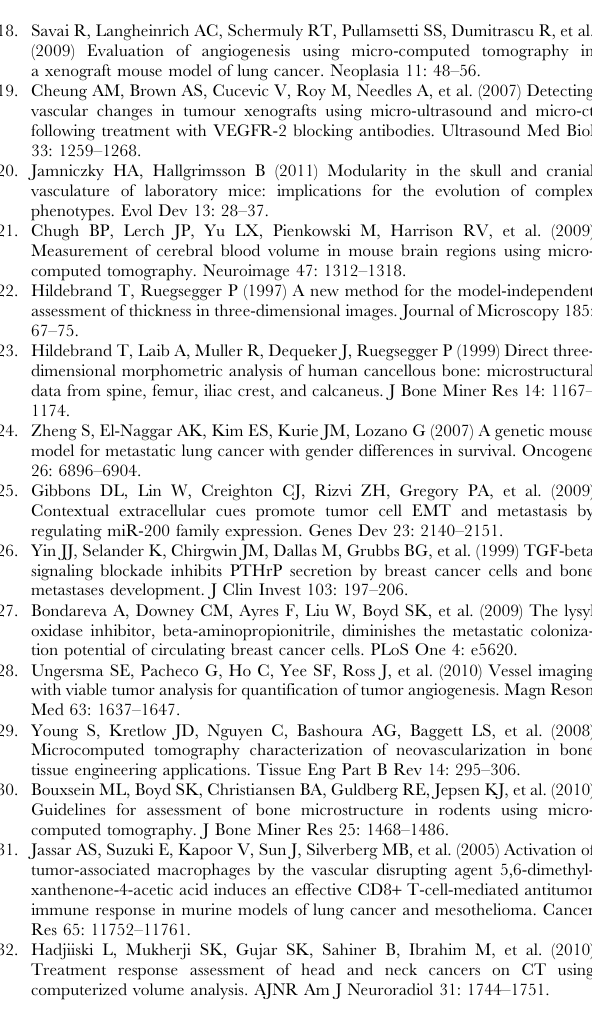
clot-filled vessels in the tumor periphery (scale bars marked on images). Figure S6 Micro-CT quantification of DMXAA treated kidneys. ( A ) 3-D renderings of kidneys (gray) with vasculature (green) from DMXAA-treated and vehicle-control mice. Quanti- fication of vessel volume (VV) ( B ), vessel density (VV/TV) ( C ), vessel number (V.N) ( D ), vessel thickness (V.Th) ( E ), and vessel separation (V.Sp) ( F ), all demonstrate no significant difference between vehicle controls or DMXAA-treated mice. (TIF) Movie S1 3-D rendering of tumor vasculature. 3-D renderings of a Microfil-perfused subcutaneous tumor (344SQ cells) rotating around the central axis. Incremental images were used to generate the frames for the rotating 3-D movie for viewing. Tumor mass is represented in gray, vessels in red. (MOV) Movie S2 3-D map of vessel thickness. Vessel thickness heat map of a Microfil-perfused subcutaneous tumor (344SQ cells). Scale bar was changed in 10 m m diameter increments to generate images to use as frames to create the movie for viewing. Red scale changes from 10 m m diameter to 300 m m and back to 10 m m highlighting both the larger and smaller vessels.